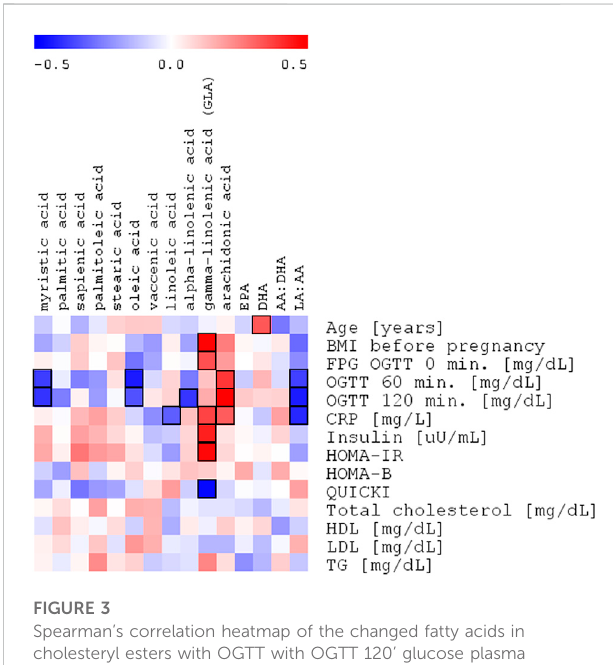
FIGURE 3 Spearman ’ s correlation heatmap of the changed fatty acids in cholesteryl esters with OGTT with OGTT 120 ’ glucose plasma concentration in the entire study group of pregnant women (NGT + GDM; n =